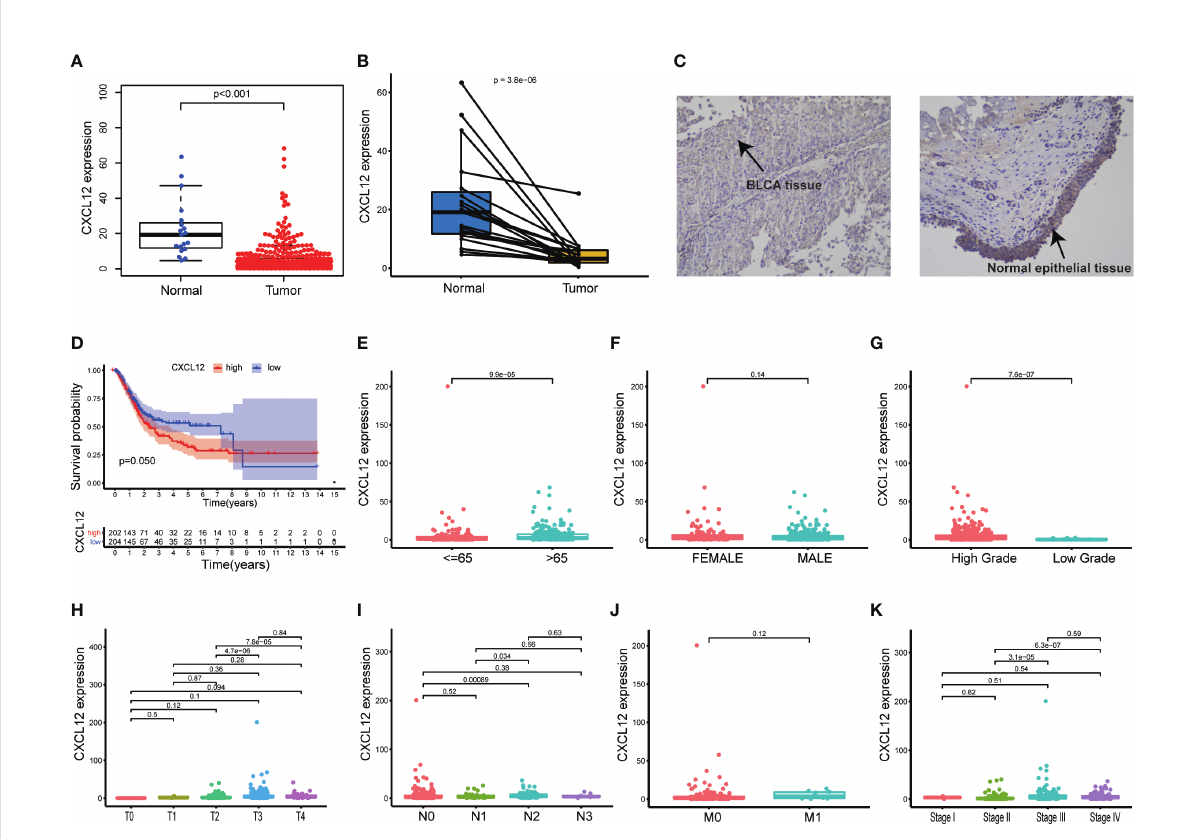
FIGURE 5 Single gene analysis of CXCL12 in BLCA. (A) Difference analysis of the expression of CXCL12 between BLCA samples and normal samples; (B) Paired analysis of the expression of CXCL12 between BLCA samples and paired normal samples; (C) The expression of CXCL12 in BLCA tissues and normal epithelial tissues; (D) Survival analysis of the expression of CXCL12 and the BLCA patients ’ survival; patients were grouped into high CXCL12 group and low CXCL12 group, compared with the median; p value and the number of samples were displayed in the diagram; (E – K) The relationship between the expression of CXCL12 and clinic – pathological characteristics of BLCA patients, including age, gender, pathology grade, TNM classi fi cation and stage; p value was displayed in the diagram and p<0.05 was considered to be statistically signi fi